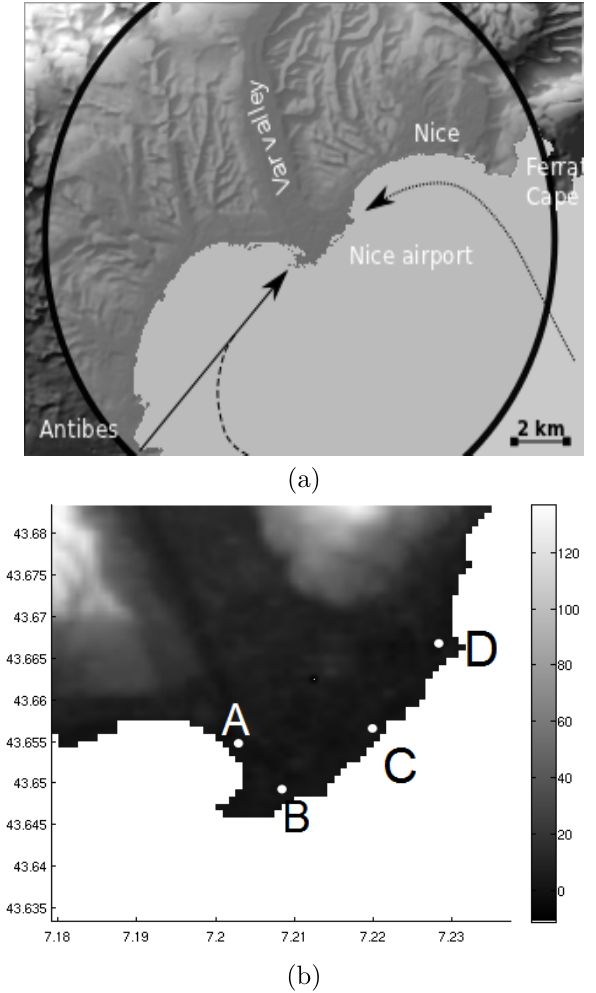
Fig. 1. Location of the Nice airport on the Shuttle Radar Topogra- phy Mission (SRTM) map of the Nice region and airplane routes represented as arrows (a) . Approach routes of the airplanes are di- rect (continuous line), in easterly wind and good visibility condi- tion (dashed line) and in westerly wind conditions (dotted line). The black and shaded circle represents the scan area of the wind lidar. (b) Zoom on the Nice airport SRTM topography and sensor location during the LIDAR2009 measurement campaign. The letters corre- spond to the different sensors: ultrasonic anemometer and wind pro- filer (A), west anemometer and wind lidar (B), central anemometer (C), east anemometer